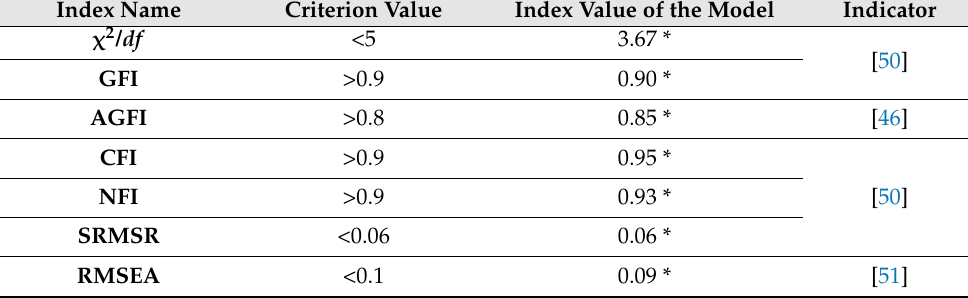
Table 4. CFA model fits.